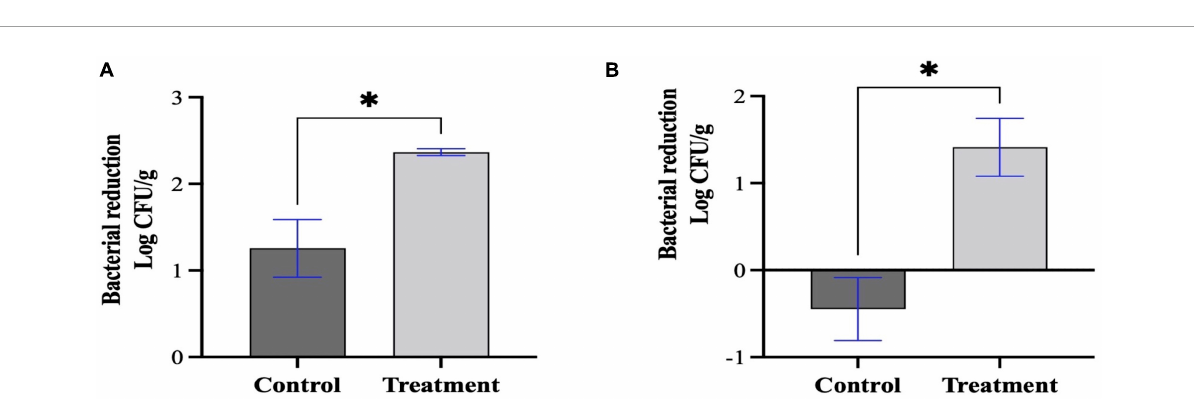
FIGURE7 Bacterial reduction of E. coli O157:H7 (A) and Salmonella Typhimurium (B) treated by Sa157lw at an MOI of approximately 6,000 for 1 h at room temperature. Both control (bacteria only) and treated mung bean seeds were stored at 22 ◦ C for 20 h prior to bacterial quantification. The initial inoculation levels on the mung bean seeds for E. coli O157:H7 and Salmonella Typhimurium were 2.36 and 2.86 log CFU/g, respectively. Asterisk indicates a significant difference at P < 0.05 between the control and treatment groups.